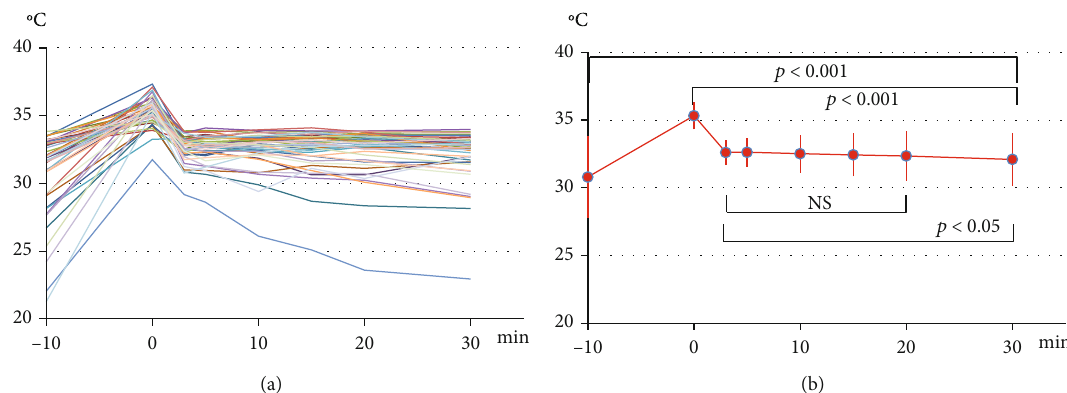
Figure 2: (a) Time-course changes in m-Temps of both hands in 47 patients. The m-Temp of each patient is plotted in a single line. (b) Means and SDs of m-Temps. m-Temp: mean nailfold temperature.